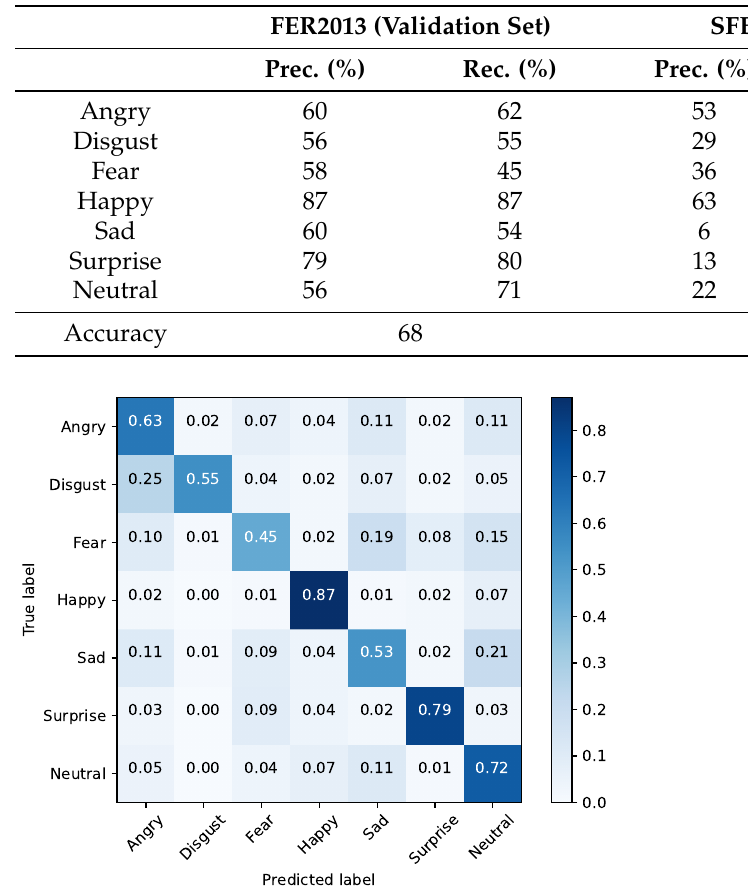
Figure 6. DenseNet—training set (FER2013). Table 6. Precision, recall and accuracy in FER2013 and SFEW.